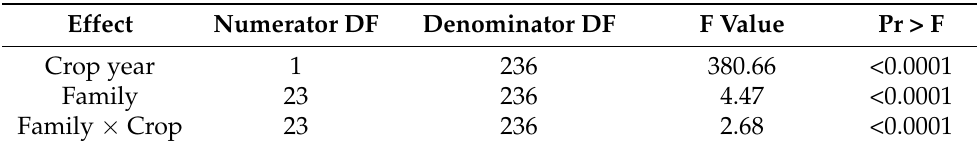
Table 2. Statistical significance of fixed effects for sugarcane seedling plot cane yield measured in plant cane and second